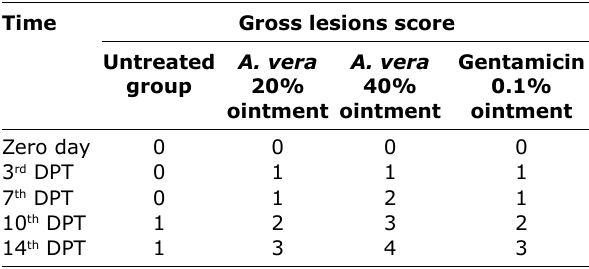
n=Number. Means with different letter superscripts in the same column are significantly different at (p<0.05). A. vera = Aloe vera , ALT=Alanine aminotransferase, AST=Aspartate aminotransferase, DWT=Day without treatment, DPT=Days post-treatment Table-3: Gross lesions score of experimental infection of dog skin with S. aureus and topical treatment with A. vera 20%, 40%, and gentamicin 0.1% ointments.